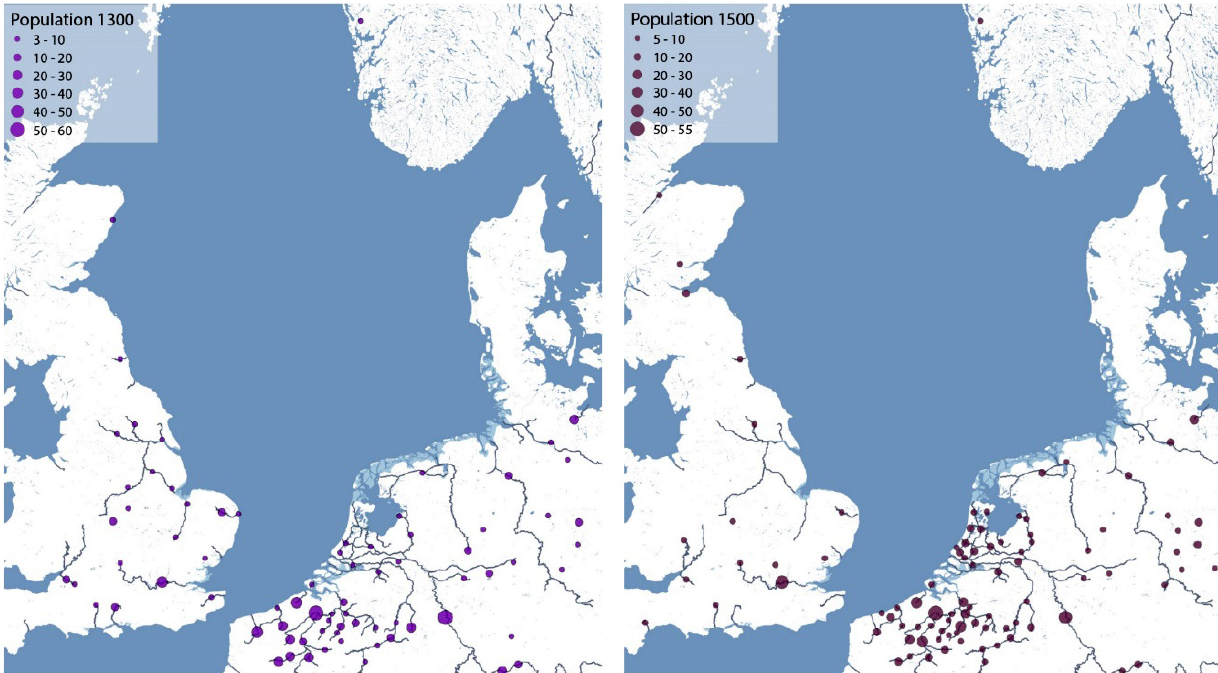
Figure 3. Cities around the North Sea area with the largest populations in 1300 and 1500, combined with the main water courses. Map by Yvonne van Mil. Source: van Mil and Rutte (2020a,